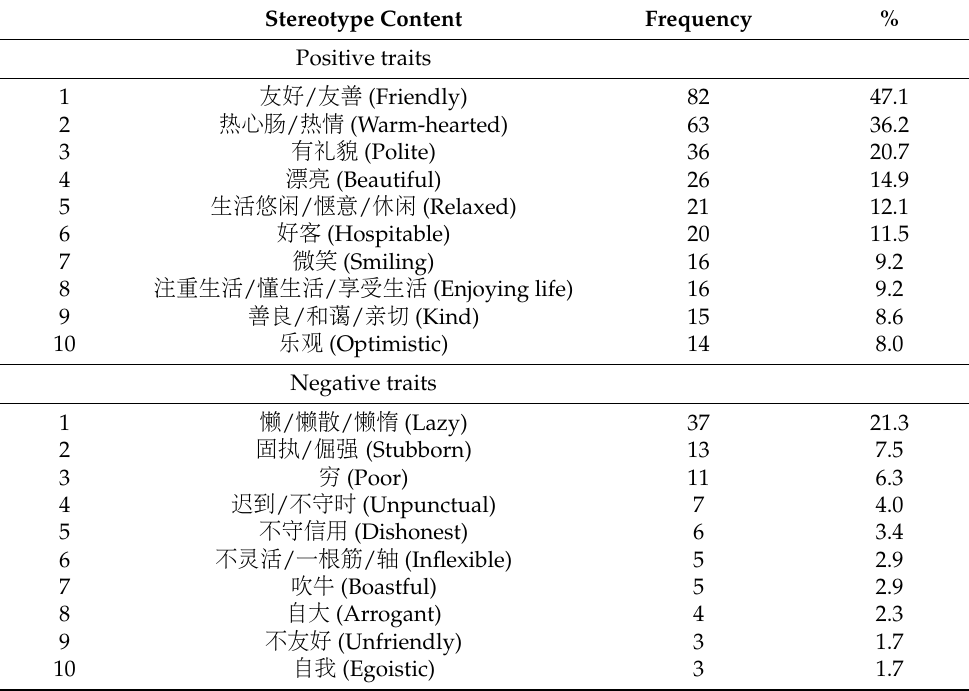
Table 1. Stereotype content of Montenegrins mentioned by the Chinese